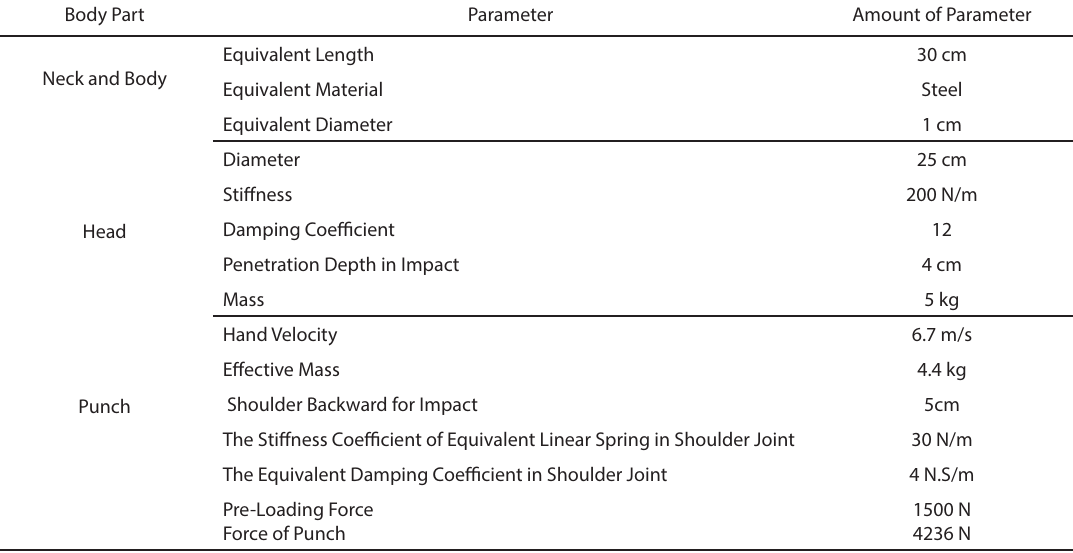
Table 1. Physical and Mechanical Parameters of Simulated Organs Body